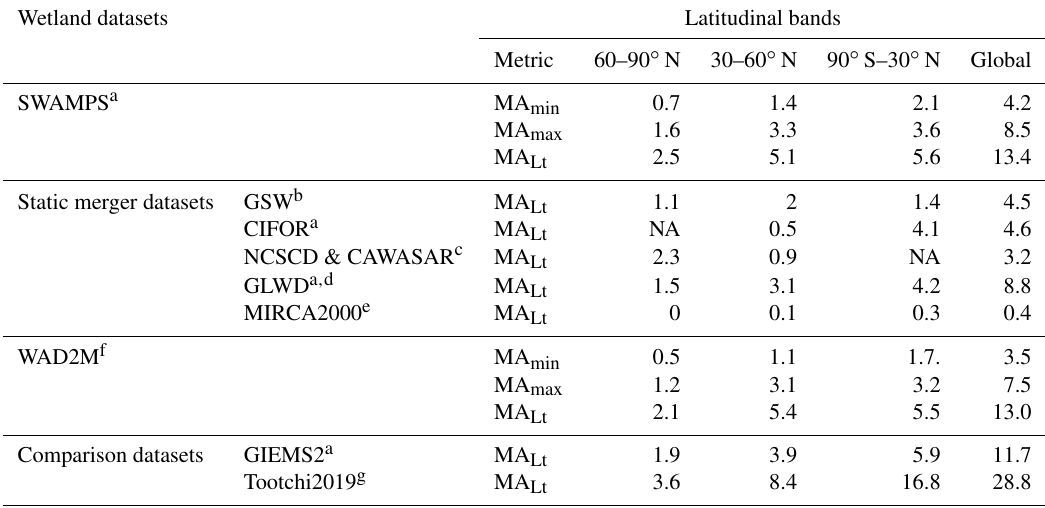
a Represents inundated area. b Represents open water. c Represents peatlands and mineral wetlands. d GLWD excludes rivers, lakes, and reservoirs; wetland classes interpreted to be in middle range. e Represents irrigated rice paddies. f Includes both inundated and non-inundated wetlands but excludes artificial inundation and lakes, ponds, and reservoirs. g For Tootchi et al. (2019), we use the composite wetland map based on the topography–climate wetness index (CW-TCI) version and exclude lake areas. NA – not